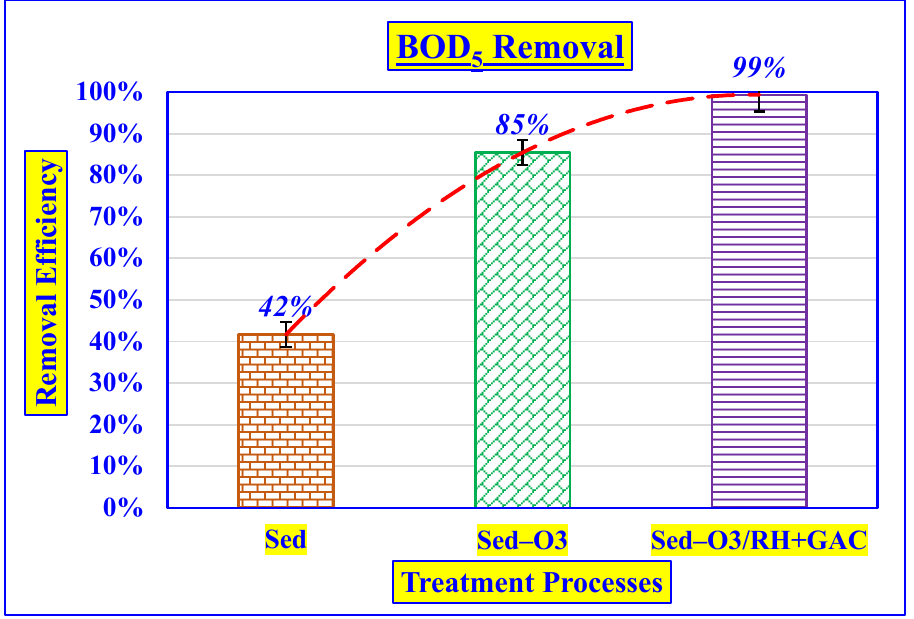
Figure 8. BOD 5 removal by hybrid system (Initial BOD5 = 225 ± 9 mg/L; O 3 = 82.5 ± 2.2 mg/L; peristaltic pump speed = 150 rpm; C.T = 18 min; GAC = 200 g; RH = 200 g; pH = 6.9 ± 0.2; volume = 4 L; T = 25 ± 2 ◦ C). Table 4. Quality of treated ASSWW sample by a novel hybrid method .